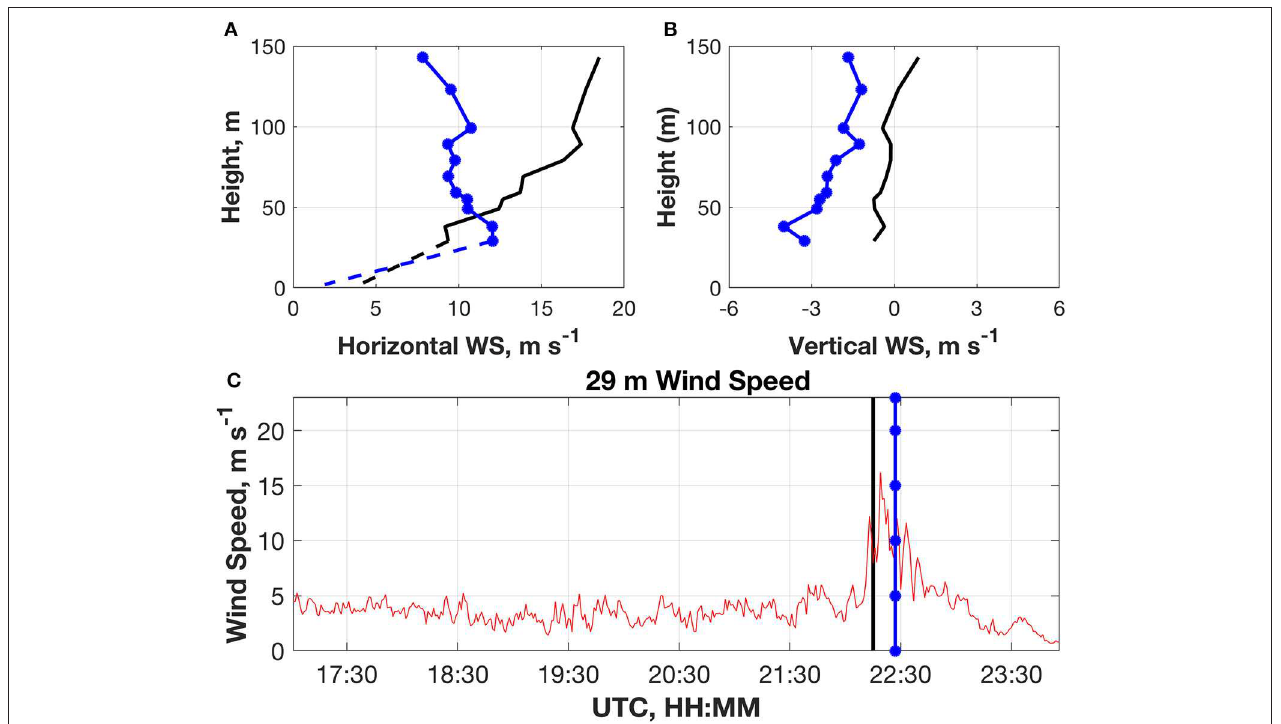
FIGURE 7 | Comparison of the 1min averaged (A) horizontal velocity profiles and (B) vertical velocity profiles at two different times (C) from the 23 July 2017 thunderstorm event. The profiles from earlier in the outflow are drawn in black, while the profiles from later in the outflow are drawn in blue.